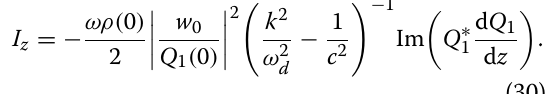
Here and below asterisk denotes complex conjugation. With the vertical displacement given by Eq. (27), Eq. (29) becomes